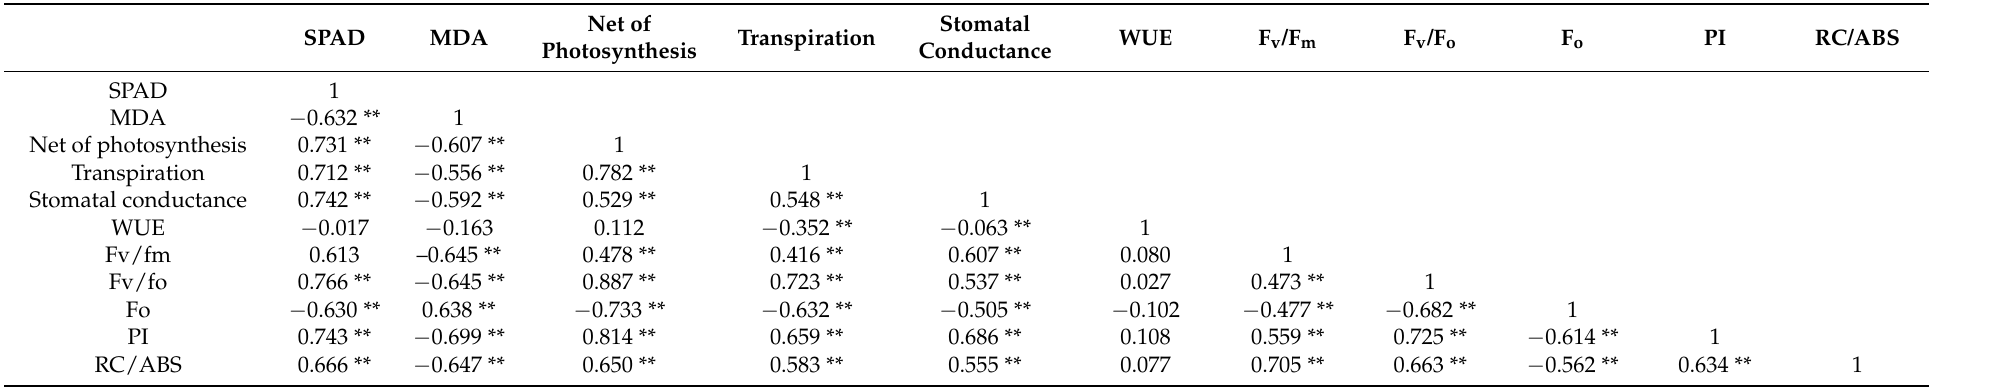
Table 9. Pearson’s correlation coefficients between physiological